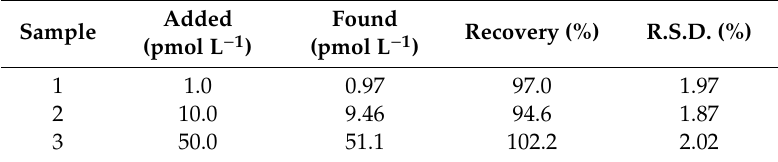
Table 2. Determination of RIF in serum samples ( n =